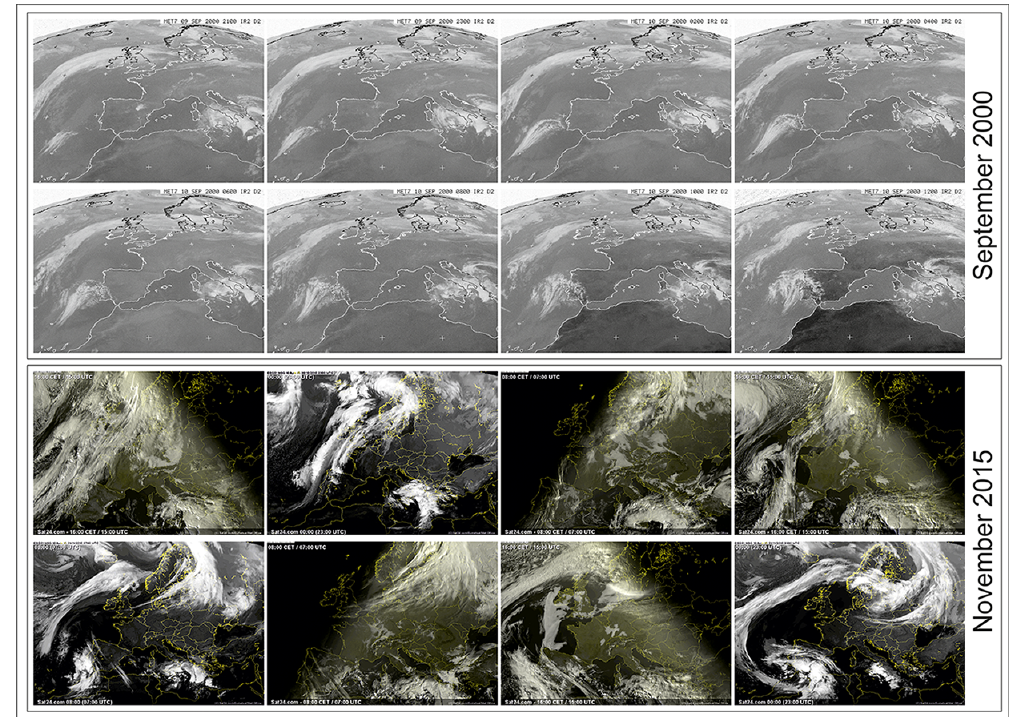
Figure 2. Meteorological framework of the western Mediterranean area during the 2000 and 2015